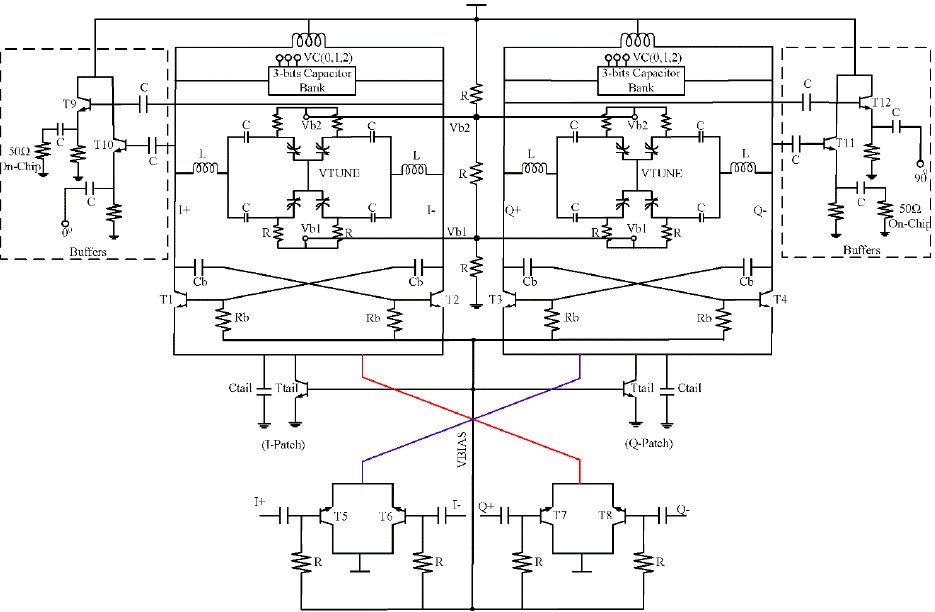
Figure 9. A simplified schematic of the superharmonically coupled Quadrature Voltage Controlled Oscillator (QVCO) with proposed wideband varactor circuits.